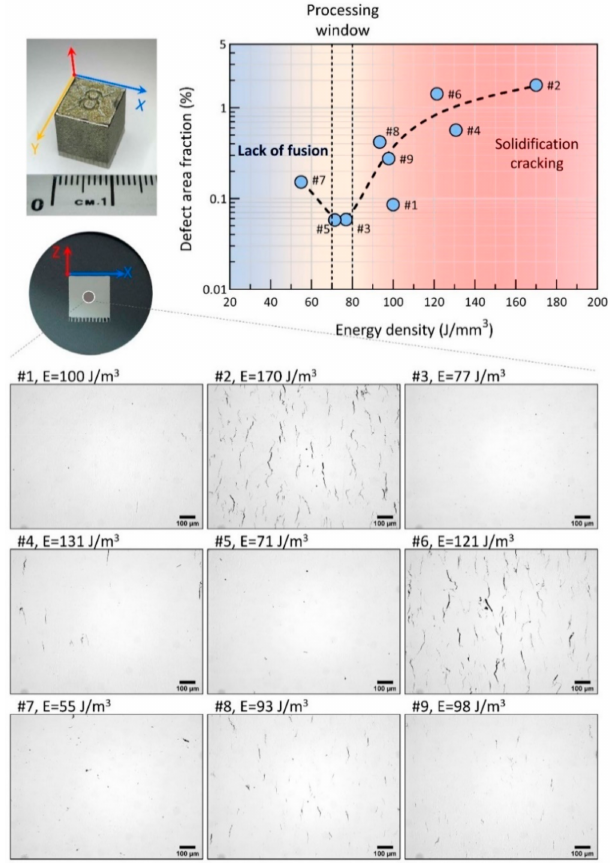
Figure 1. Laser powder bed fusion (LPBF) processing window investigation of MAD542 superalloy on 10 mm × 10 mm × 10 mm cubes. With lower energy density input, the major defects are dominated by lack of fusion, while higher energy density inputs result in micro-cracks. The crack-free part is provided by #3 printing parameters, which has a suitable energy density input for